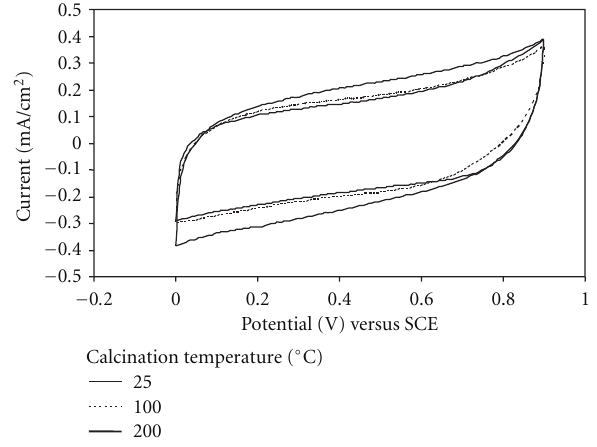
Figure 5: Cyclic voltammograms of self-assembled MnO 2 thin films calcined at various